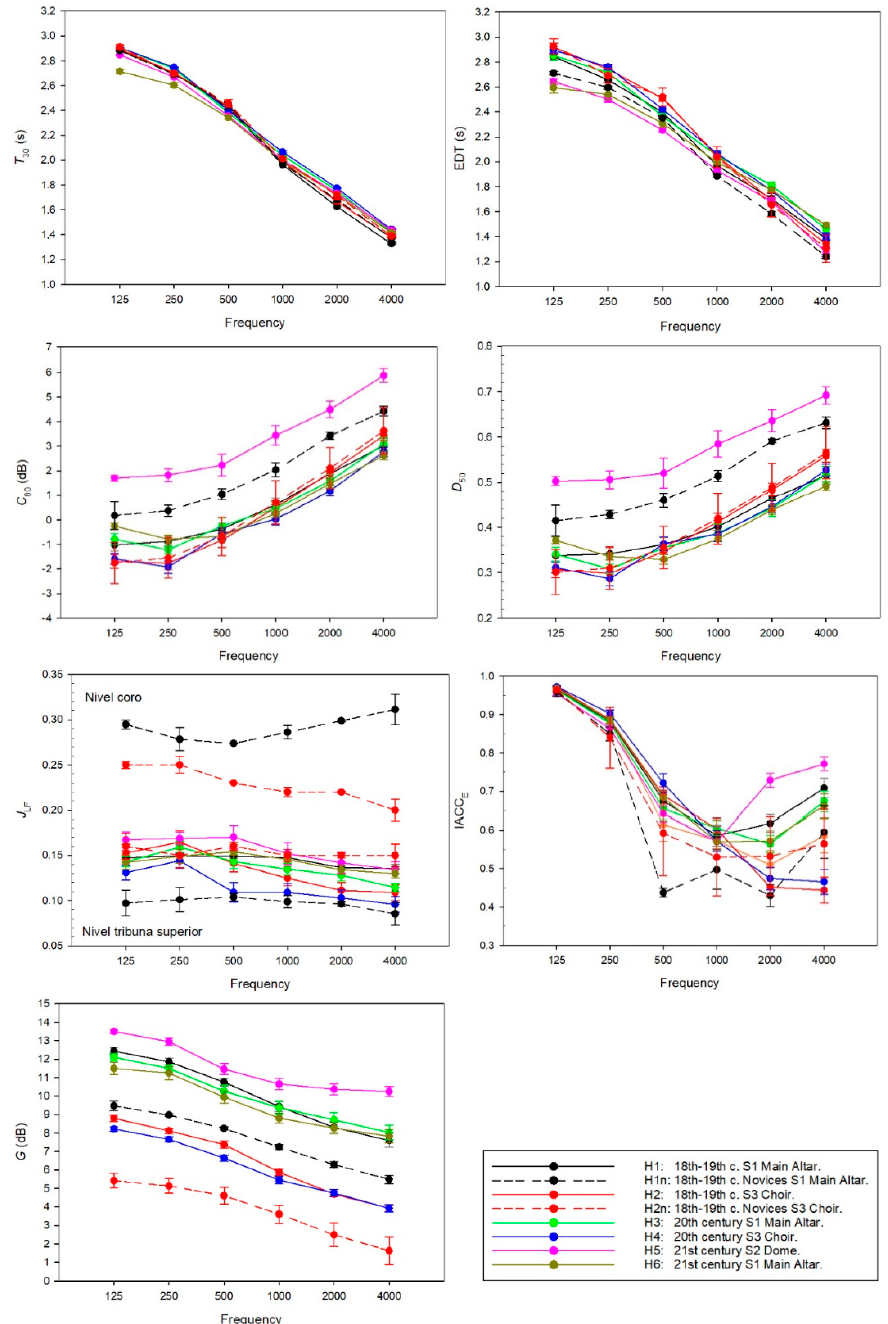
Figure 9. T 30 , EDT, G , C 80 , D 50 , J LF and IACC E spatially averaged versus frequency octave band and error bars (standard error) for the different simulation hypotheses.